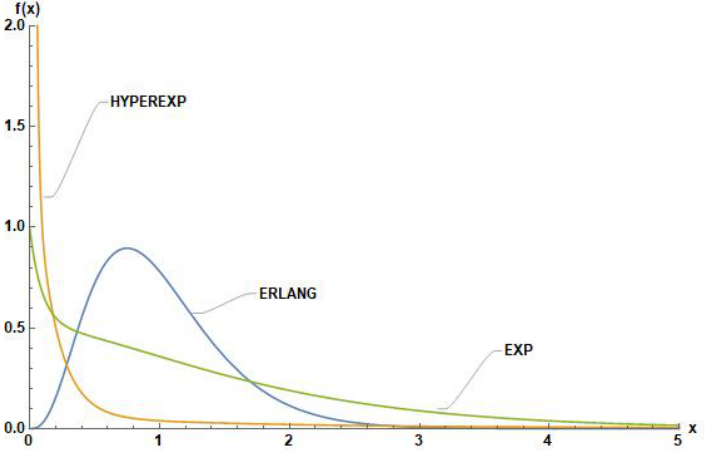
Figure 3. Probability density function of the service